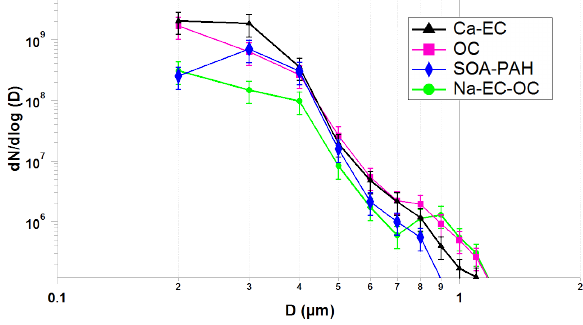
Fig. 3. Size distributions of the 4 ATOFMS particle types described in Fig.